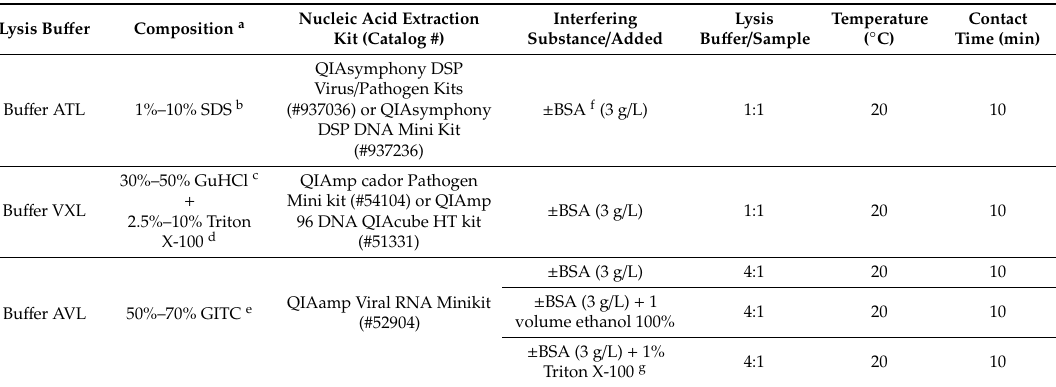
Table 1. Protocols tested for assessing inactivation using lysis bu ff ers.